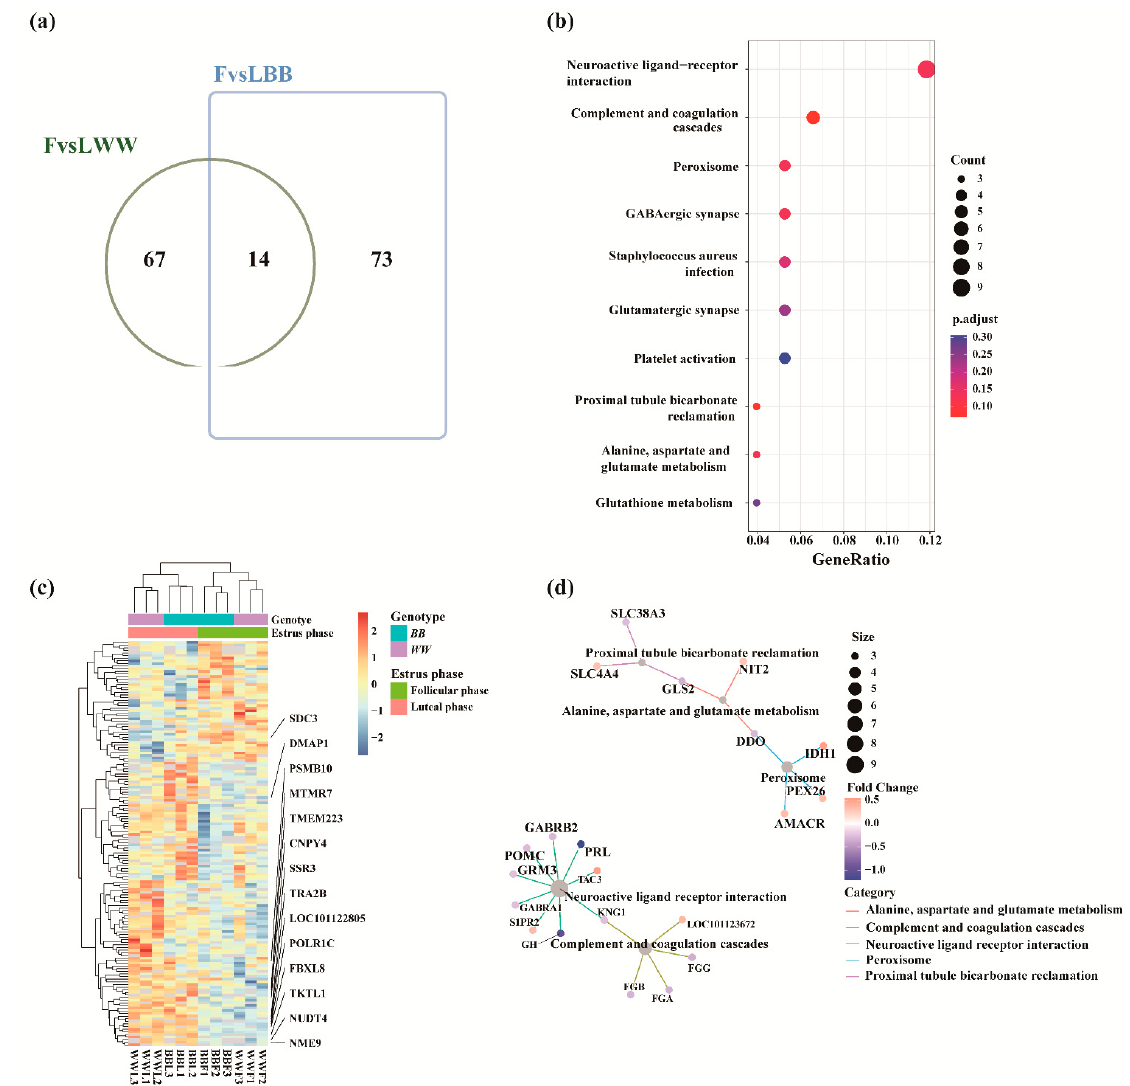
Figure 4. Analysis of DAPs. ( a ) Venn plot displaying the overlap of DAPs between the FvsLWW and FvsLBB groups. ( b ) Dotplot of the top 10 KEGG enrichment terms for DAPs concatenations in the FvsLWW and FvsLBB groups. pAdjust: false discovery rate (FDR). ( c ) Hierarchical cluster of DAPs in the FvsLWW and FvsLBB groups in which all of the abundance values of proteins were normalized and scaled. ( d ) Networks of the top 10 KEGG enrichment terms were visualized by cnetplot. FvsLWW: follicular phase relative to the luteal phase in WW sheep; FvsLBB: follicular phase relative to the luteal phase in BB sheep.